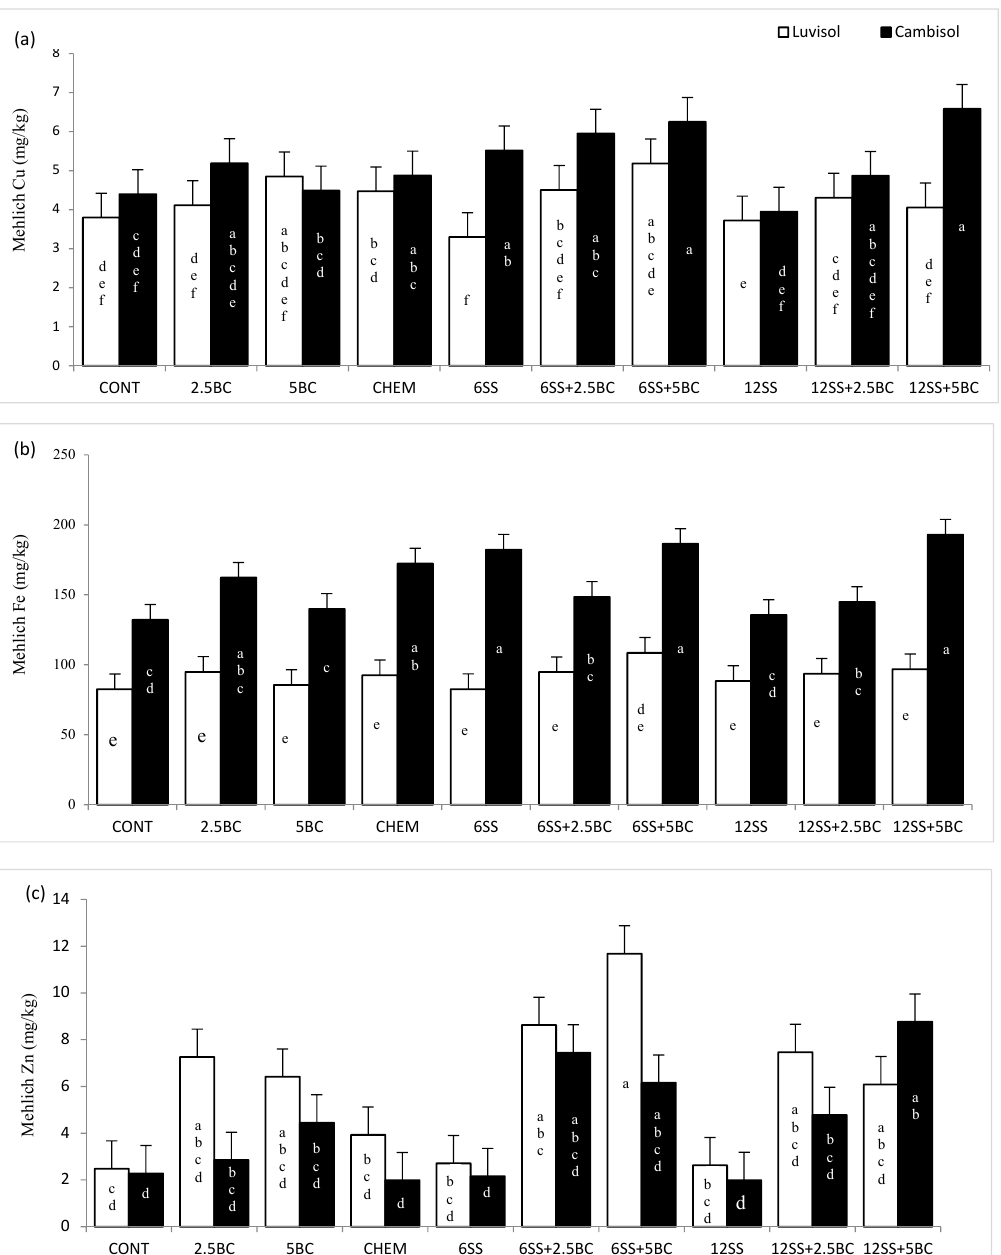
Figure 1. Mehlich-extractable contents of ( a ) Mehlich Cu, ( b ) Mehlich Fe, ( c ) Mehlich Zn at the end of the season. For each variable, columns for both soil types with different letters are significantly different ( p < 0.05) according to Duncan’s multiple range test. Comparison of treatment means for both soil types indicate the statistics were done simultaneously. Error bars denote standard error of the mean (SEM) ( n = 3).